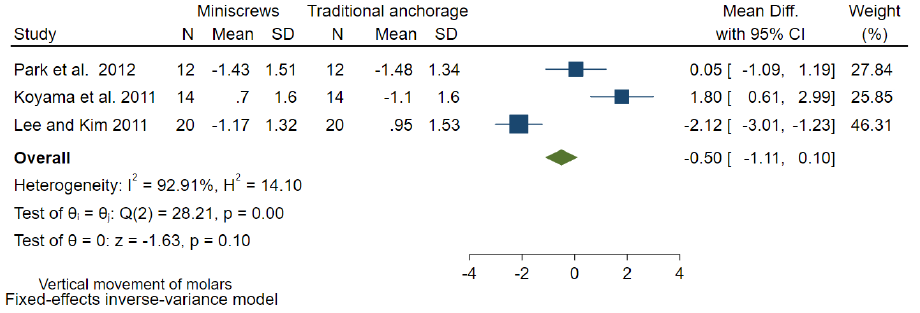
Figure 3. The Forest plot showed the vertical movement of molars between miniscrews vs. traditional anchorage.